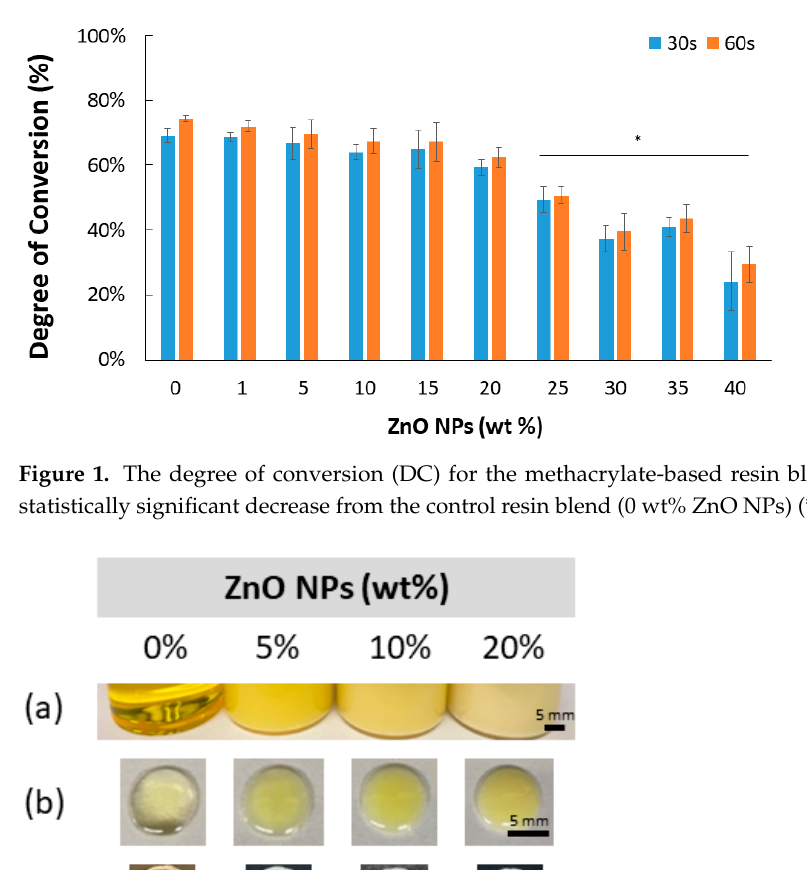
Figure 2. ( a ) Resin blend within storage vial. ( b ) Drop of resin blend on the glass slide prior to light curing. ( c ) Resin disk following fabrication.